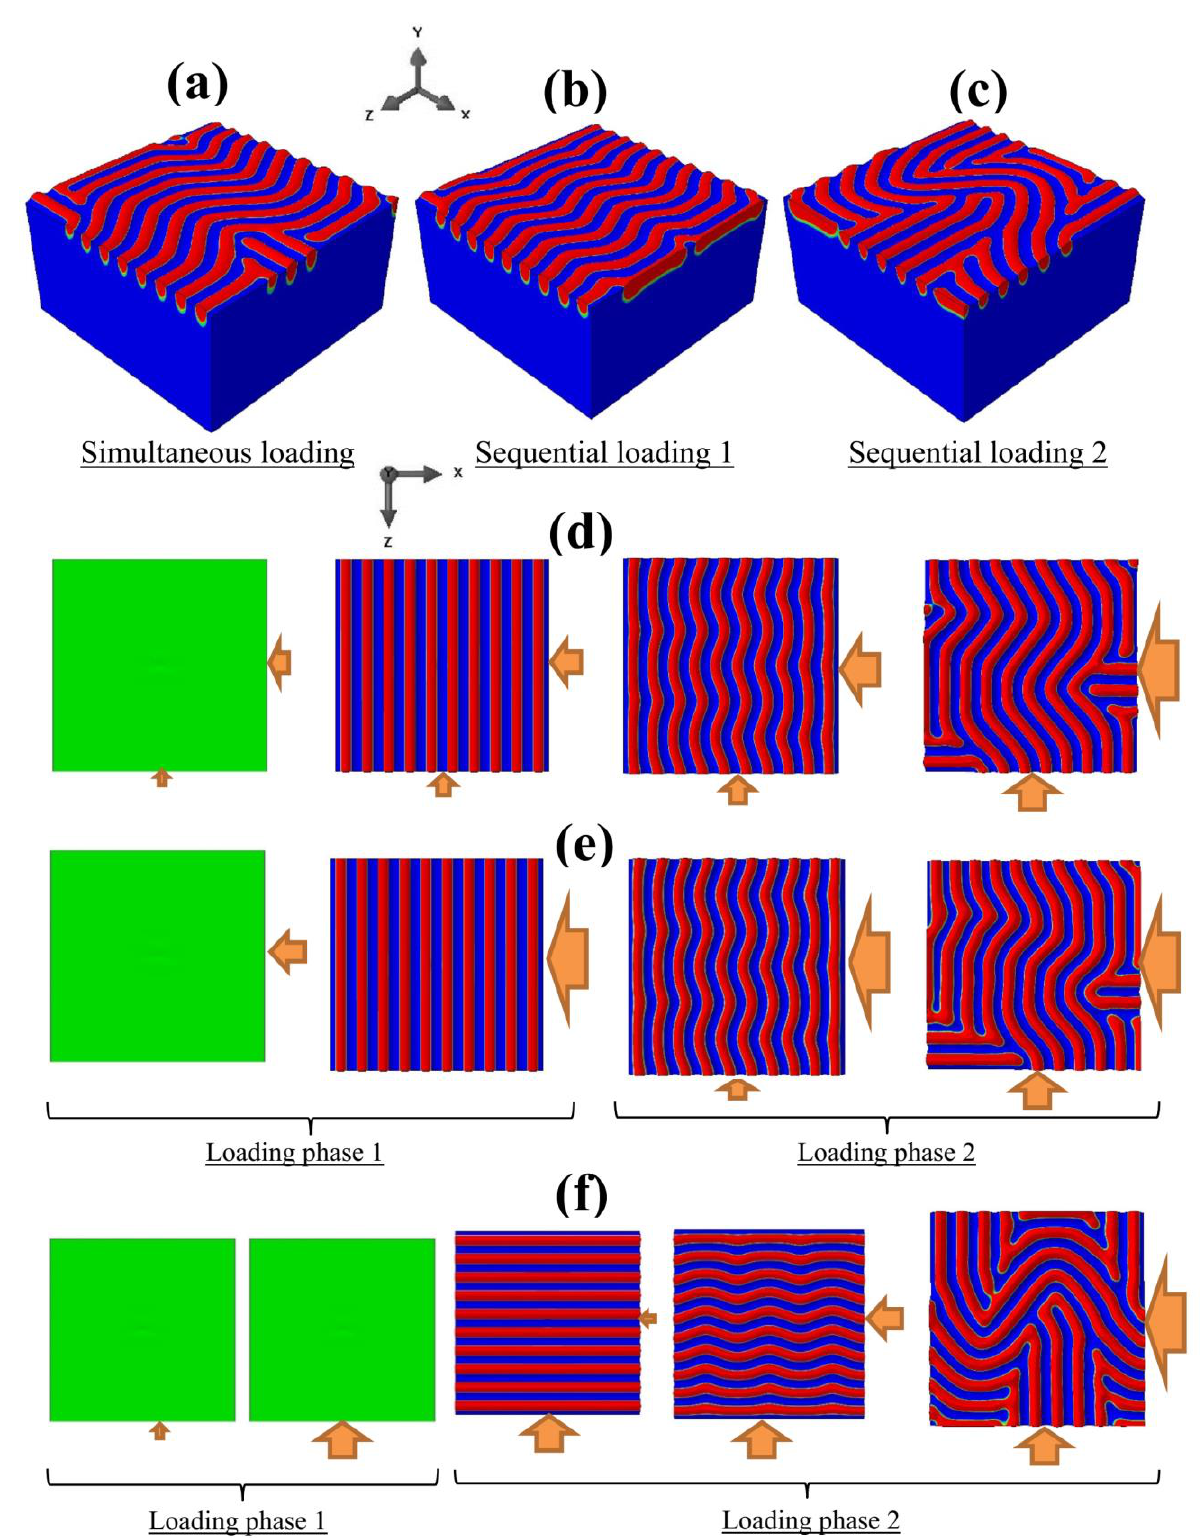
Figure 7. Snapshots of the simulated wrinkling patterns for BR = 0.7 and 𝑒 𝑥𝑥 𝑒 𝑐𝑟 ≅ 1.96⁄ , for the case of ( a , d ): simultaneous loading, ( b , e ): sequential loading 1, and ( c , f ): sequential loading 2. The wrin- kling configurations at the end of each simulation are presented in ( a – c ). The evolution of the wrin- kling patterns (starting from a flat surface until reaching the target strains) are shown in ( d – f ). The directions of the applied displacements are also schematically shown.